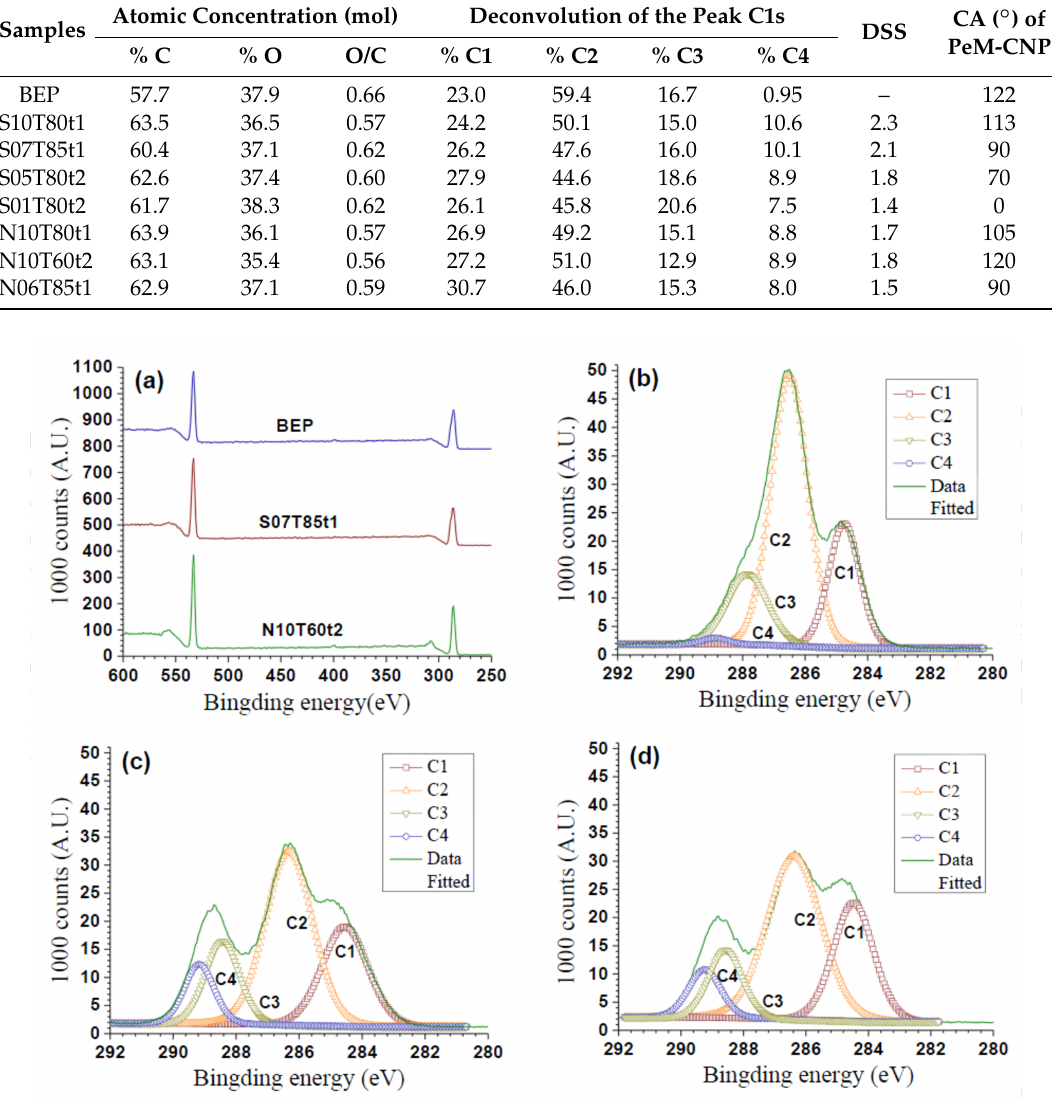
Figure 5. XPS spectra ( a ); deconvolution of the C 1s peak: BEP ( b ); CNM-S07T85t1 ( c ); and CNM-N10T60t2 ( d